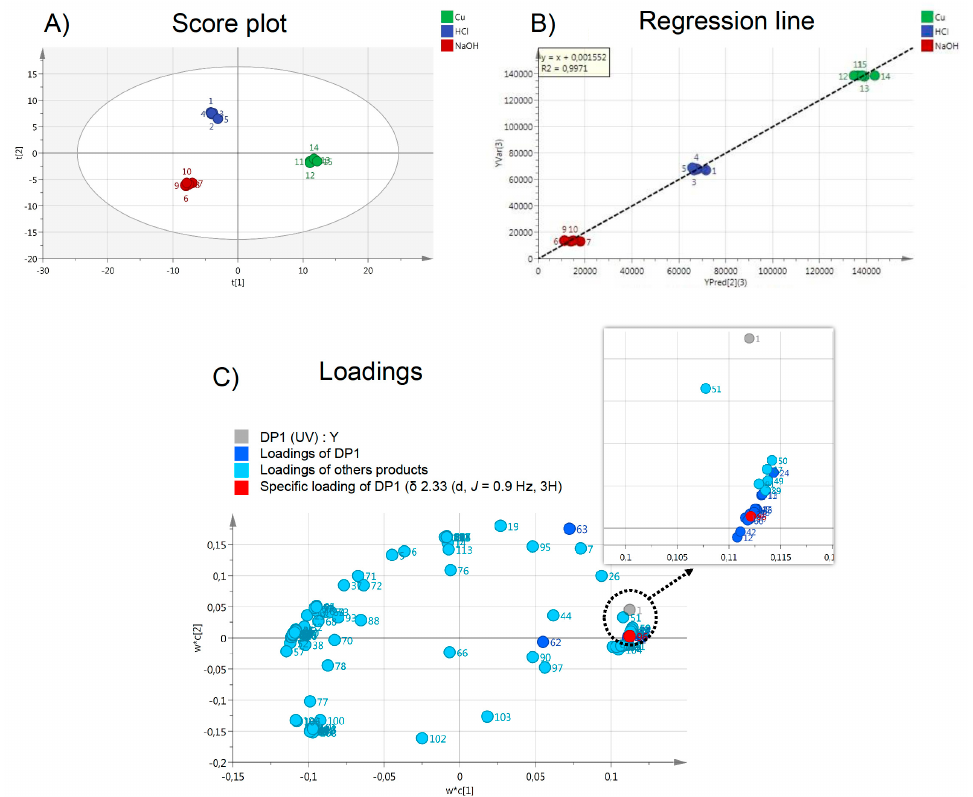
Figure 6. Partial least squares (PLS) results based on the DP1 signals observed in forced degradation mixtures (HCl, NaOH, Cu(II)). The NMR (X) and UV / MS (Y) data set were employed for PLS model construction, as follows: ( A ) score plot, ( B ) regression line, and ( C ) loadings. NB: loadings in dark blue indicate the chemical shift bins that present the most important correlation with the corresponding UV / MS response (as exemplified in red for the DP1 H 21 characteristic proton, Table 1).